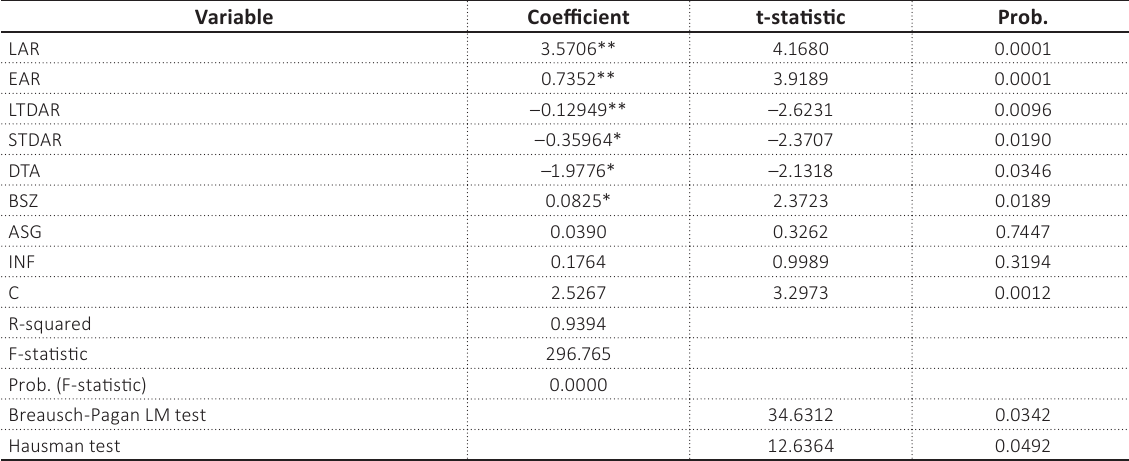
Table 4. The influence of the capital structure on banks’ performance measured by